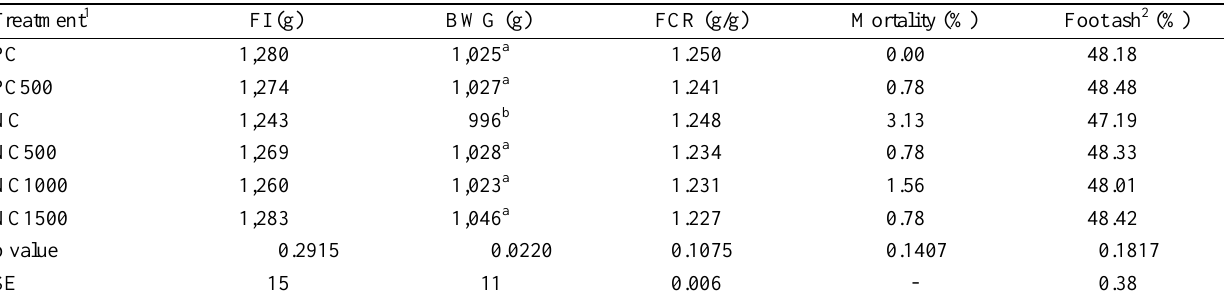
Table 3. Analysis of variance of the effect of P level and phytase inclusion on FCR, BWG, FI, mortality and foot ash of broilers at 21 d Treatment